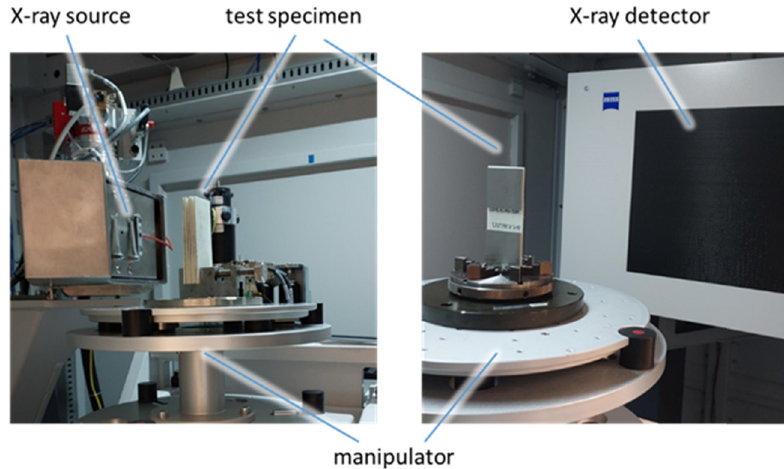
Figure 5: Setup of an X - ray computed tomography system with ( a ) source and ( b ) detector with a stack of separated CFRT components of ( a ) the 1D samples positioned on the manipulator and a single multi - pin array made of ( b ) stainless steel and